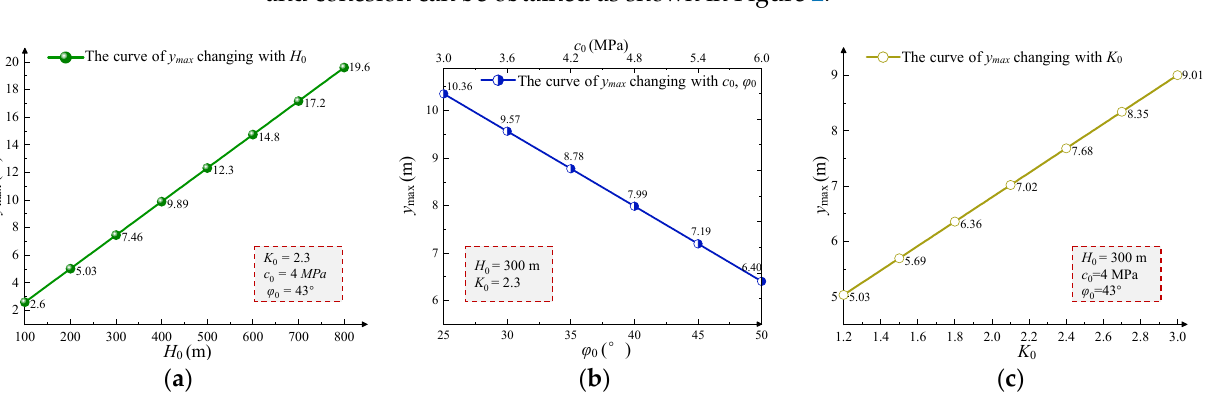
From Equation (7), the relationship between the depth of floor damage caused by mining and the depth of burial, the stress concentration factor, the internal friction angle, and cohesion can be obtained as shown in Figure 2.